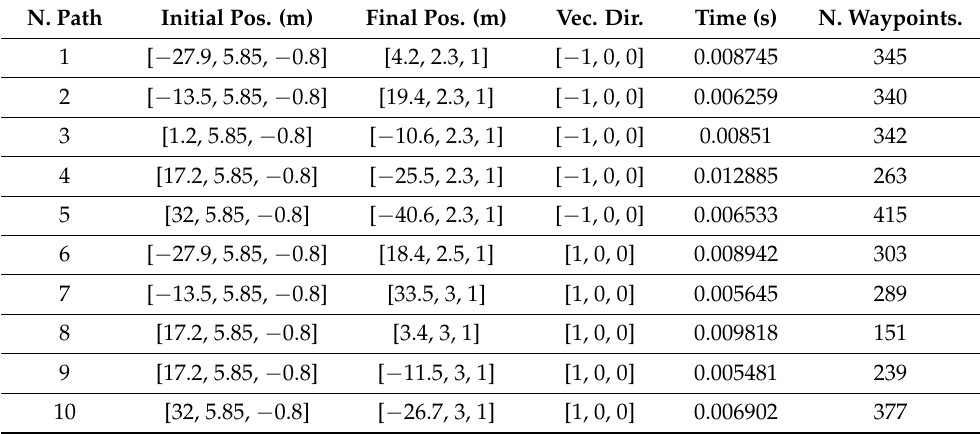
Table 1. Result of different path calculations.